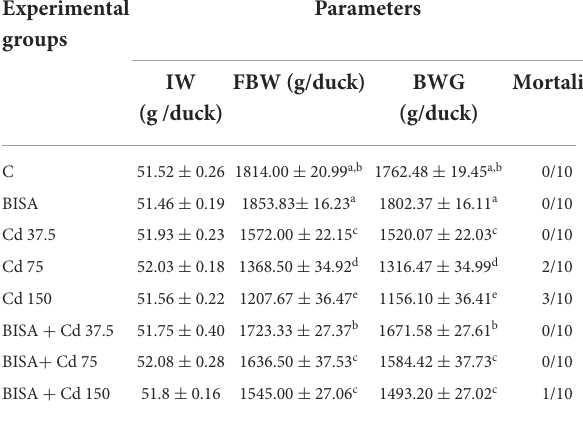
TABLE 2 Effect of α -bisabolol on body weight changes and mortality in ducks receiving CdCl 2 in feed for 4 weeks. Experimental groups